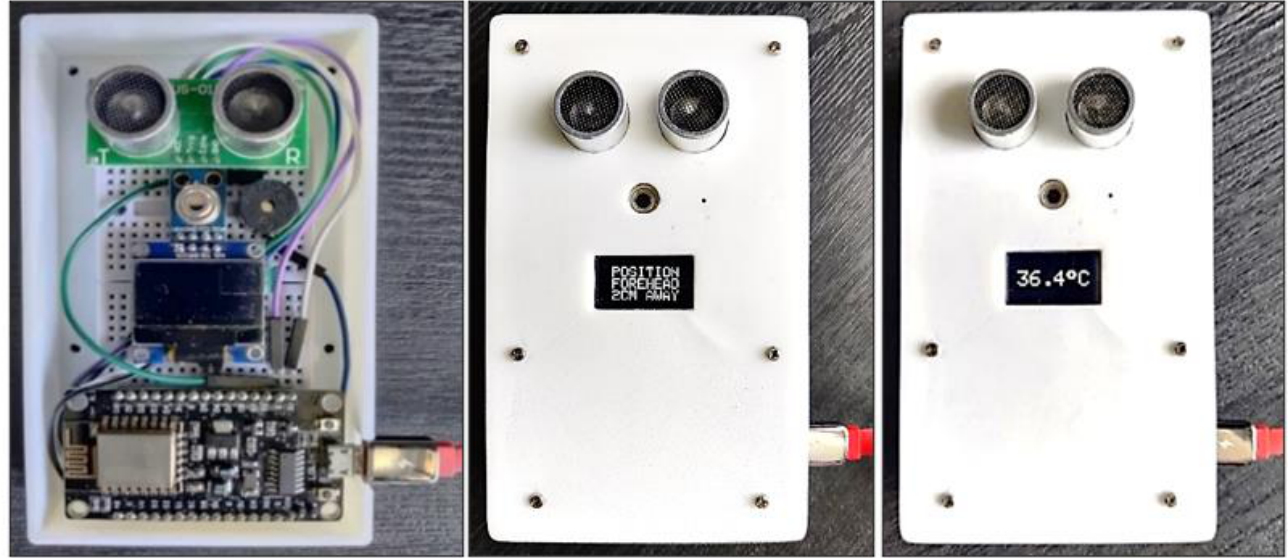
Figure 6. Assembly of the body temperature screening system.